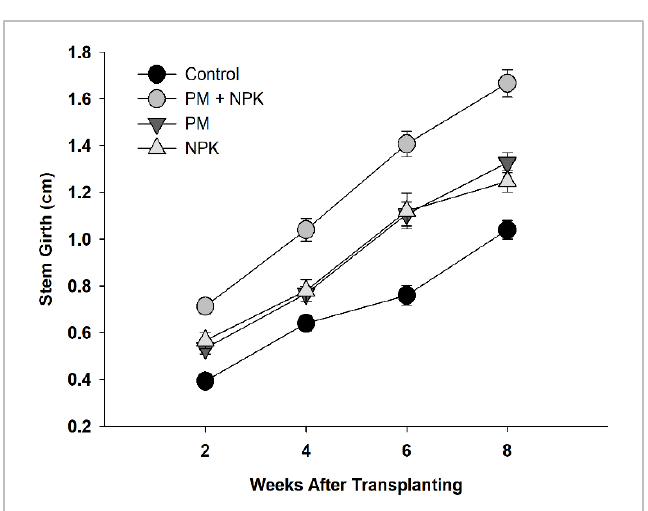
Means (±SD) with different letters in columns differ